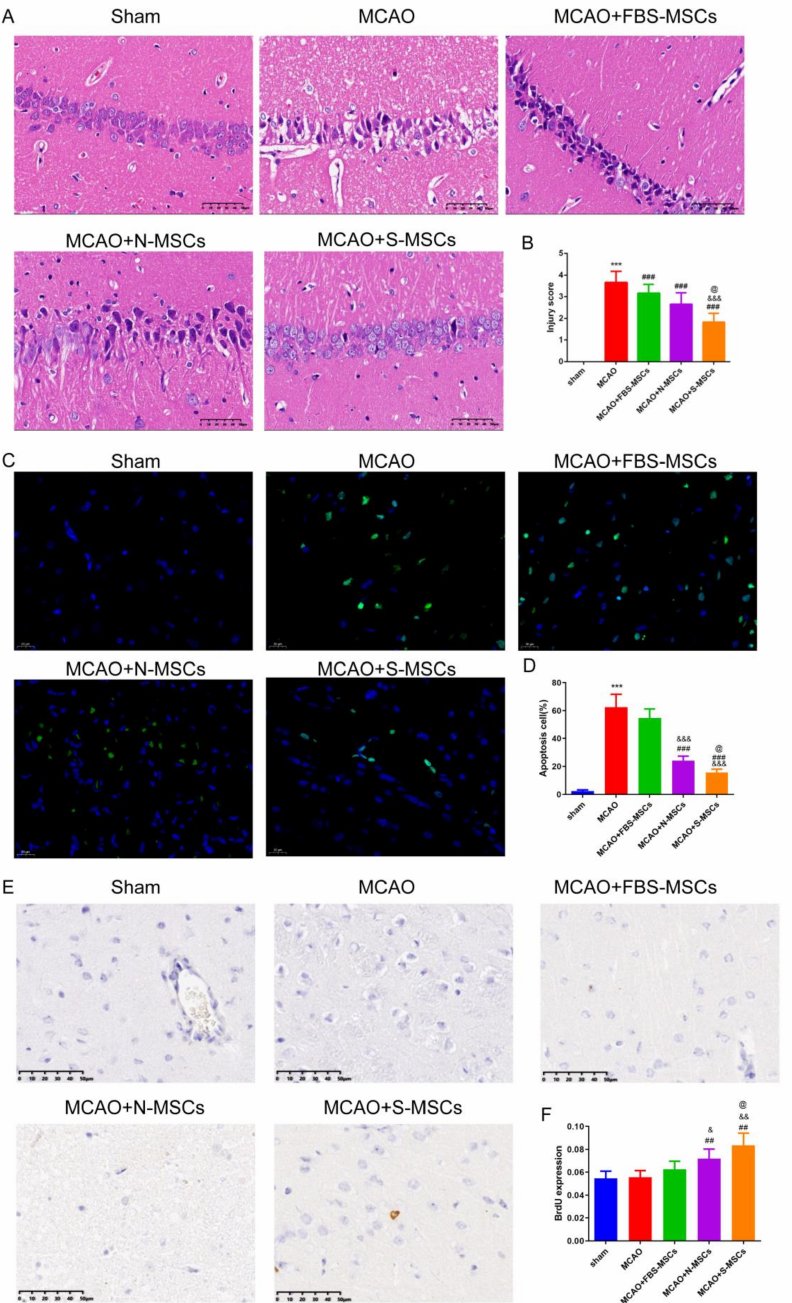
Figure 6. ( A ) Brain tissue recovery in MCAO rats (HE staining, × 400). ( B ) Quantitative analysis of the injury score using ImageJ software. ( C ) TUNEL double staining was performed to evaluate neuronal apoptosis in slices from right ischemic cortices (Scale bar = 100 µ m). ( D ) Quantitative analysis of the AI using ImageJ software. ( E ) Detection of BrdU expression in brain tissue of rats with ischemia-reperfusion cerebral infarction ( × 400). ( F ) Quantitative analysis of the BrdU using ImageJ software. Compared with the sham group, *** p < 0.001; compared with the MCAO group, ## p < 0.01, ### p < 0.001; compared with the MCAO + FBS-MSCs group, & p < 0.05, && p < 0.01, &&& p < 0.001; compared with MCAO + N-MSCs group, @ p < 0.01. ( x ± s, n =